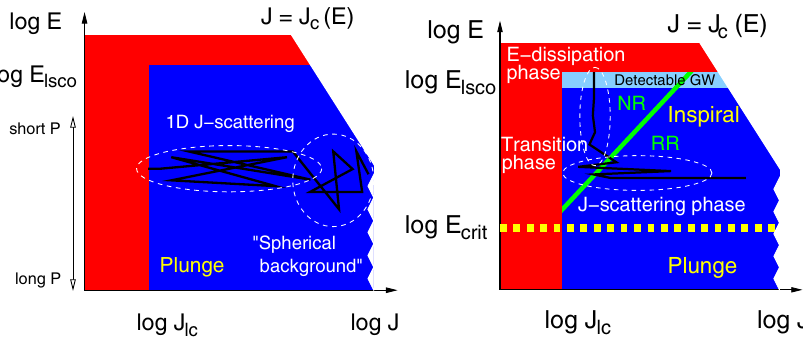
Fig. 42 Plunge, inspiral and critical energy of an EMRI in phase-space. Left panel: Direct plunge of a source. Right panel: Adiabatic inspiral of a source subject to dissipation of energy at periapsis and limiting critical energy (image courtesy of Tal